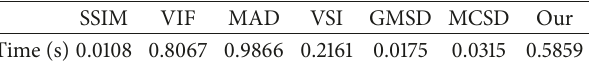
Table 7: Running time of the competing IQA methods. SSIM VIF MAD VSI GMSD MCSD